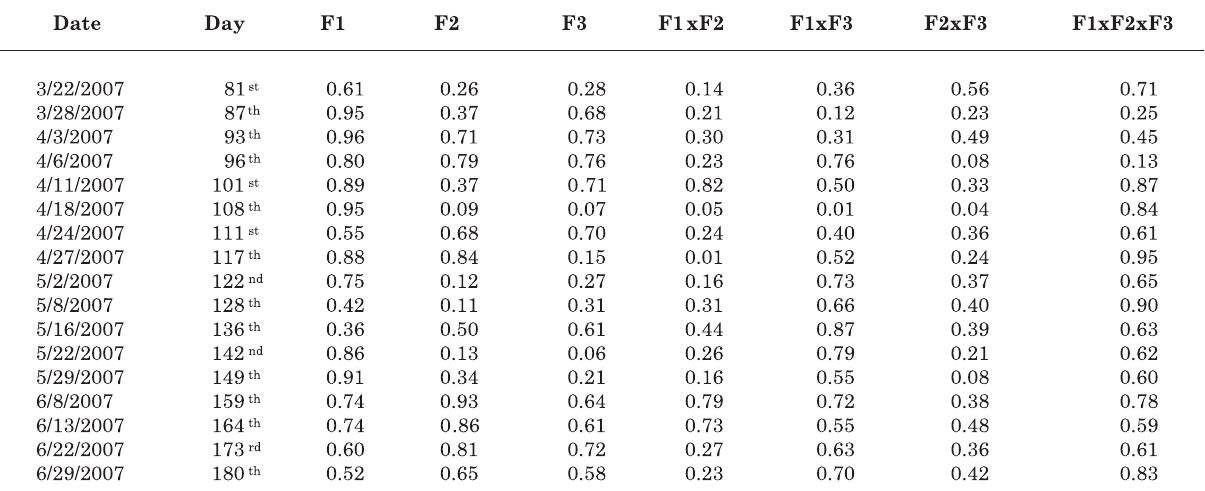
Table 1. Probabilities of influence of the factors F1 (soil tillage systems), F2 (mulching management) and F3 (rootstocks) for soil water volume in the 0–20 cm layer by the F test, in 17 assessments (March 22 to June 27, 2007), corresponding to 100 days, in the Julian calendar